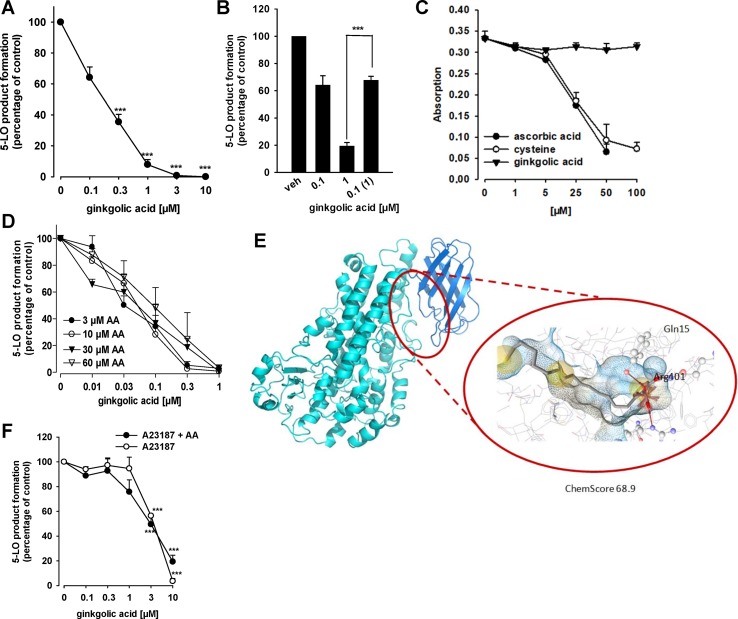
Effects of GA on 5-LO activity. (A) Inhibition of isolated 5-LO. Semi-purified human recombinant 5-LO was pre-incubated with GA or vehicle (0.1% DMSO) for 10 min at 4°C. 5-LO product formation was initiated by addition of 20 µM AA for 10 min at 37°C. Then, 5-LO products [tr-LTB4 isomers and 5-H(P)ETE] were analyzed by RP-HPLC. Means + S.E.M., n = 3, *p < 0.05 and ***p < 0.001 vs. vehicle (DMSO) control, ANOVA + Tukey HSD post hoc tests. (B) Reversibility of 5-LO inhibition. Semi-purified 5-LO was pre-incubated with 0.1 or 1 µM GA for 10 min at 4°C. One sample containing 1 µM GA was then diluted 10-fold by PBS pH 7.4 to obtain 0.1 µM GA. As control, 10-fold diluted 5-LO in PBS pH 7.4 was pre-incubated with vehicle. 5-LO product formation was initiated by addition of 20 µM AA for 10 min at 37°C. 5-LO products [tr-LTB4 isomers and 5-H(P)ETE] were analyzed by RP-HPLC. Means + S.E.M, n = 3–4, ***p < 0.001; 1 µM vs. diluted sample, ANOVA + Tukey HSD post hoc tests. (C) Radical scavenger capability. GA, vehicle and controls were mixed with DPPH solution and incubated for 30 min in the dark. The absorbance was measured at 520 nm. Means + S.E.M., n = 3. (D) Inhibition of 5-LO by GA at various substrate concentrations. Semi-purified human recombinant 5-LO was pre-incubated with GA or vehicle (DMSO) for 10 min at 4°C. 5-LO product formation was initiated by addition of the indicated concentrations of AA for 10 min at 37°C. 5-LO products [tr-LTB4 isomers and 5-H(P)ETE] were analyzed by RP-HPLC. Means + S.E.M., n = 3, *p < 0.05 and ***p < 0.001 vs. vehicle (DMSO) control, ANOVA + Tukey HSD post hoc tests. (E) GA docked into an allosteric binding site of 5-LO, located between the membrane binding domain (dark blue) and the catalytic domain (light blue). Chemical interactions are color-coded: yellow spheres, hydrophobic; red arrows, hydrogen bond acceptor; red star, ionic interaction. The surface is colored by aggregated hydrophilicity (blue)/hydrophobicity (gray). Amino acids participating in hydrophilic interactions are depicted in ball-and-stick style. (F) Inhibition of 5-LO product synthesis by GA in intact cells. PMNL (5 × 106/ml) were pre-incubated with GA or vehicle (DMSO) for 10 min at 37°C and stimulated with 2.5 µM A23187 or 2.5 µM A23187 plus 20 µM AA. 5-LO products (LTB4, tr-LTB4 isomers and 5-HETE) were determined by RP-HPLC. Means ± S.E.M., n = 3–5, ***p < 0.001 vs. vehicle (DMSO) control, ANOVA + Tukey HSD post hoc tests.